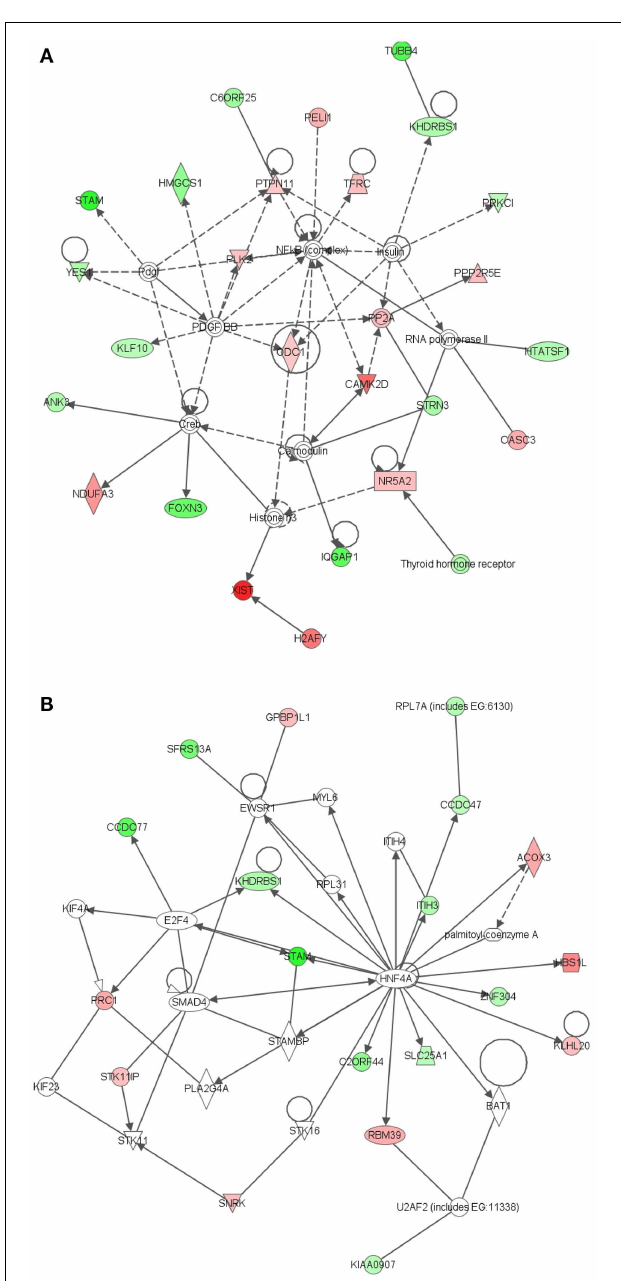
FIGURE 3 | Ingenuity PathwayAnalysis (IPA) of genes differentially expressed in LRECe vs. ECe. Genes that were differentially expressed in LRECe vs. ECe were imported into IPA software, which revealed the involvement of several networks pertinent to LRECb. Network (A) relates to cancer. Network (B) pertains to DNA replication, recombination and repair and contains a HNF4A module. Red color denotes up-regulation in LRECe and green color denotes down-regulation in LRECe relative to control cells.The IPA legend is shown in FigureA1 in Appendix.